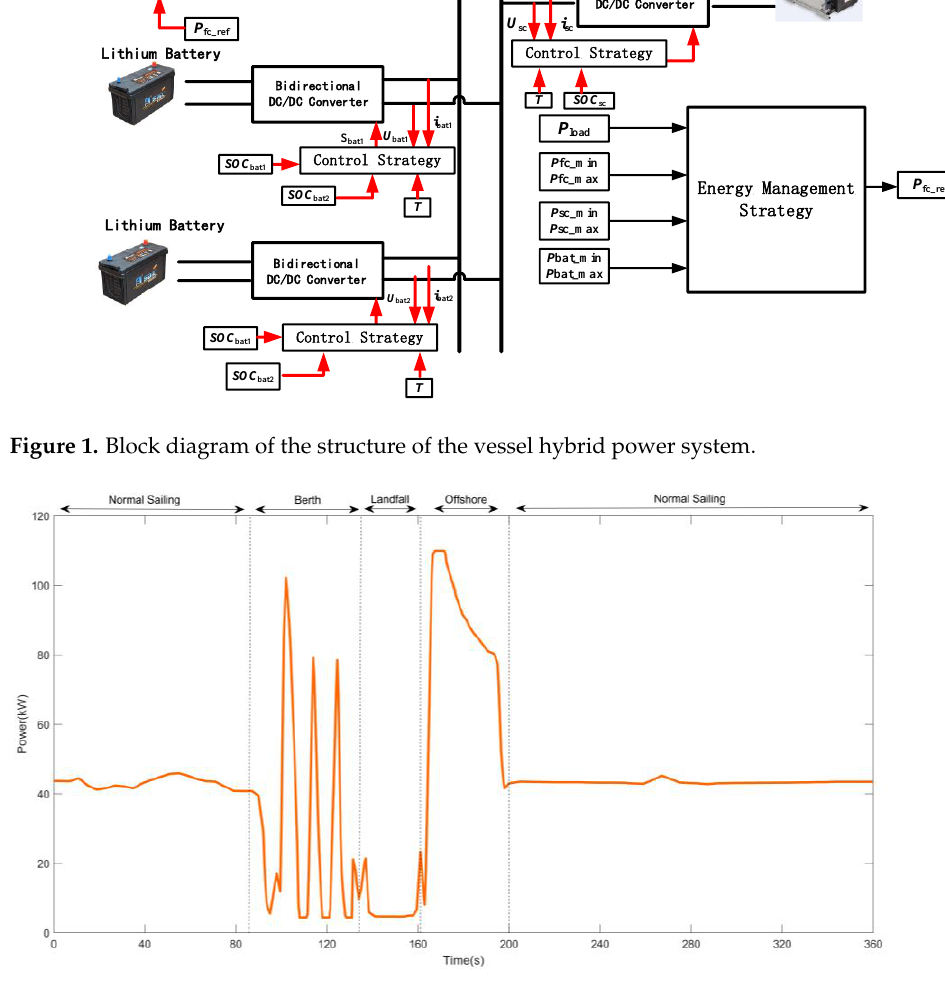
Figure 2. Power demand in a working cycle (from [11]).